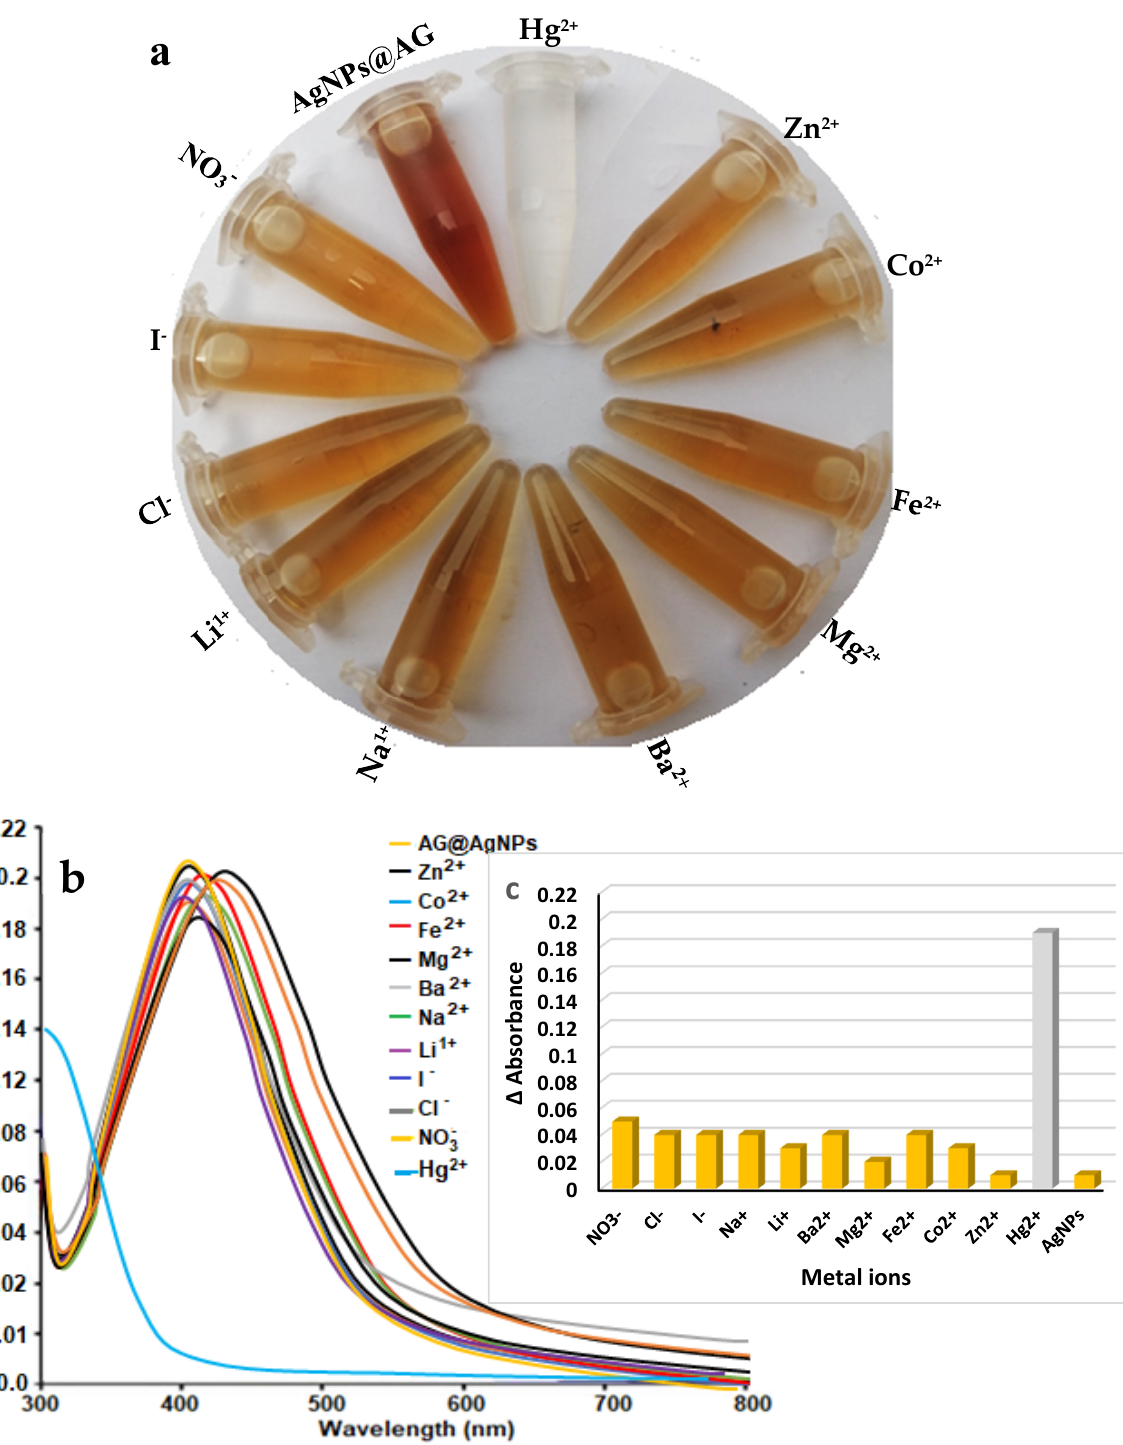
Figure 8. ( a ) Photo of the AgNPs@AG sensor performance against different groups of anions and cations; ( b ) absorbances of anionic and cationic foreign ions at certain wavelengths; ( c ) absorbance of different anions and cations at different wavelengths.